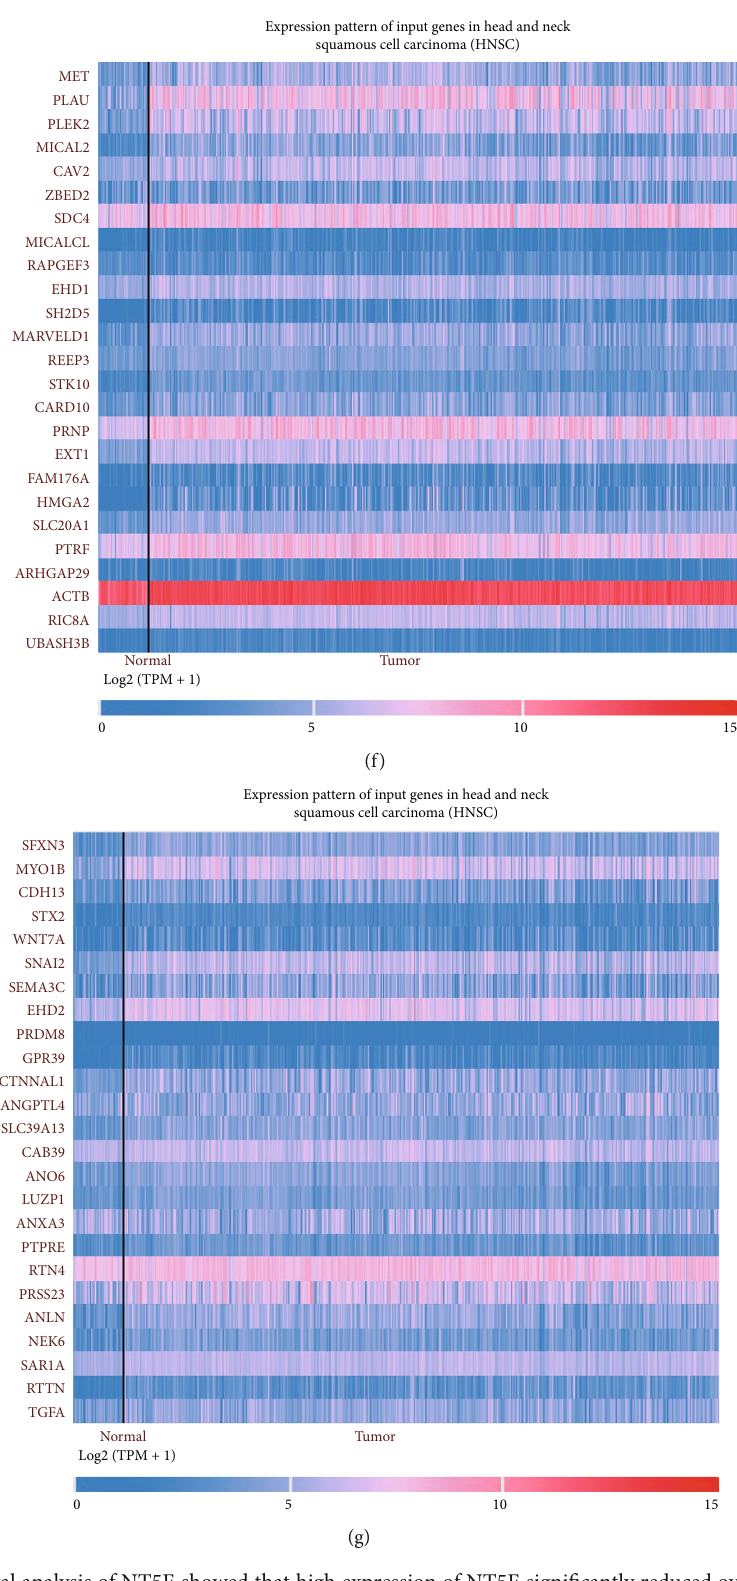
Figure 3: (a) Overall survival analysis of NT5E showed that high expression of NT5E signi fi cantly reduced overall survival in patients with HNSCC ( P < 0 : 05 ). (b) Disease-free survival analysis of NT5E showed that high expression of NT5E had no signi fi cant e ff ect on disease-free survival of HNSCC ( P = 0 : 11 ). (c) The fi rst 25 coexpressed genes of NT5E. (d) The top 25 to 50 coexpressed genes of NT5E. (e) The top 50 to 75 coexpressed genes of NT5E. (f) The top 75 to 100 coexpressed genes of